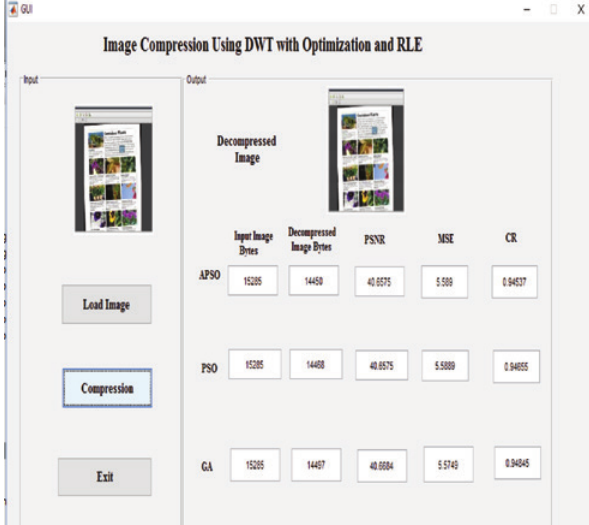
Figure 10: Graphical User Interface (GUI) in